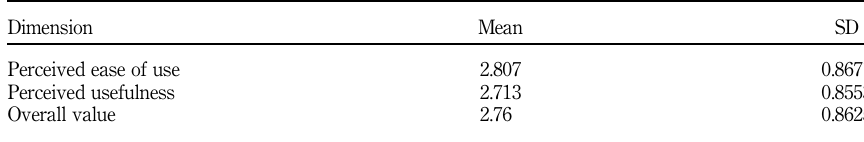
Table III. Overall mean and standard deviation based on